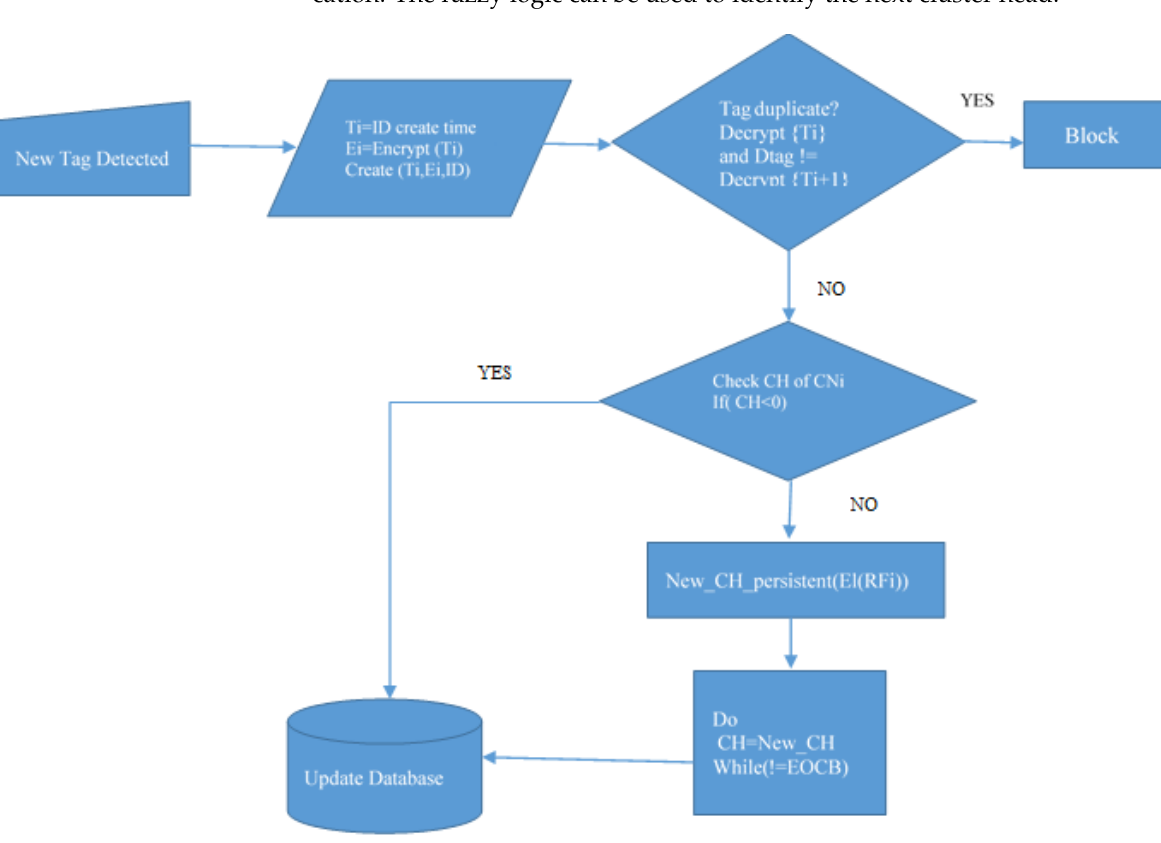
Figure 1. Working methodology of Clustered RFID.